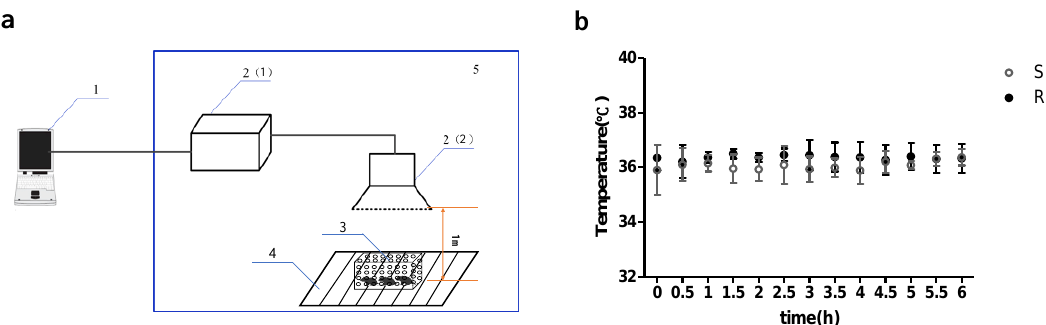
Figure 1. Schematic diagram of experimental set-up of the RF-EMR-exposure system ( a ) 1. Control system: a computer; 2. Microwave signal source. (1). Microwave source; (2). Horn antenna; 3. Experiment animals were placed at a plastic box (35 × 24 × 24 cm) with many vents on their walls; 4. Experiment platform; 5. Shielded room. Time course of changes in mice surface body temperature during 1.8 GHz RF field exposure ( b ). Data were represented as the mean ± SD. N = 6 for each group (within group: df = 12, F = 0.323, P = 0.984; between groups: df = 1, F = 2.721, P = 0.130); RF: radiofrequency.